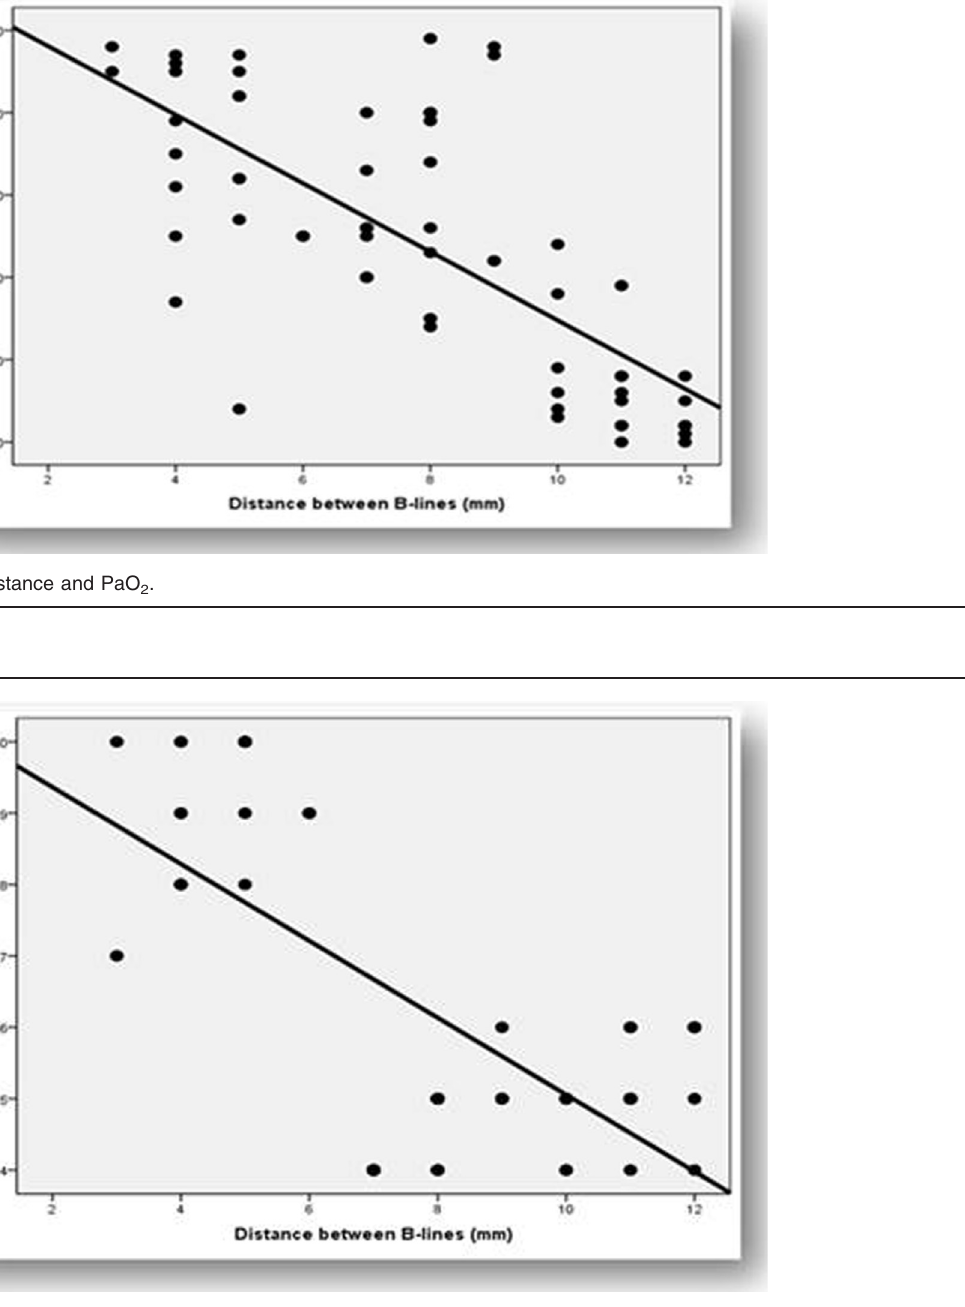
The relation between B-line distance and B-line